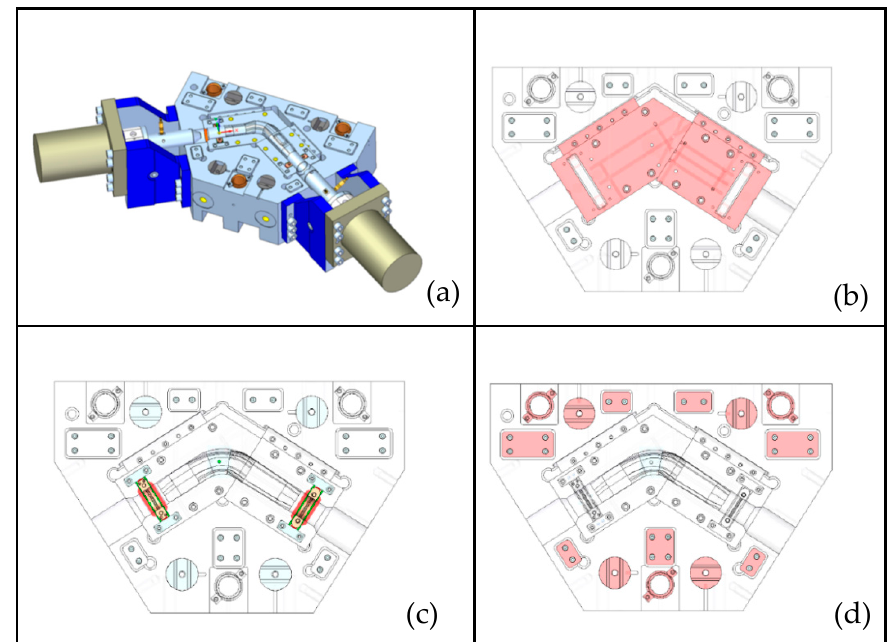
Figure 4. Bottom half of HMGF forming tool, CAD with details: ( a ) overview, ( b ) form elements, ( c ) ejector, ( d ) guiding and force absorption elements.